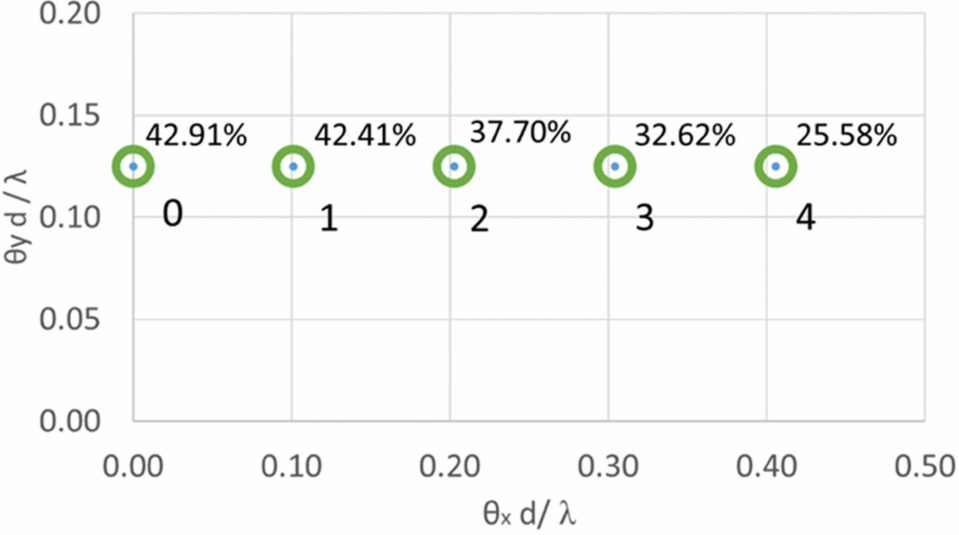
Figure 8. ROIs defined to characterize P i , j and the diffraction efficiency for k =